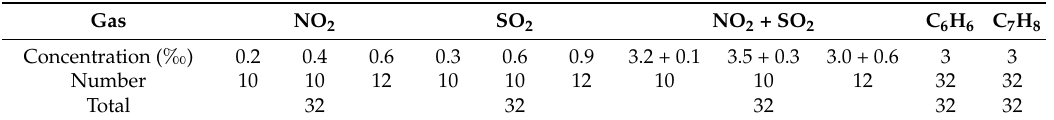
Table 3. Dataset consisting of 2D